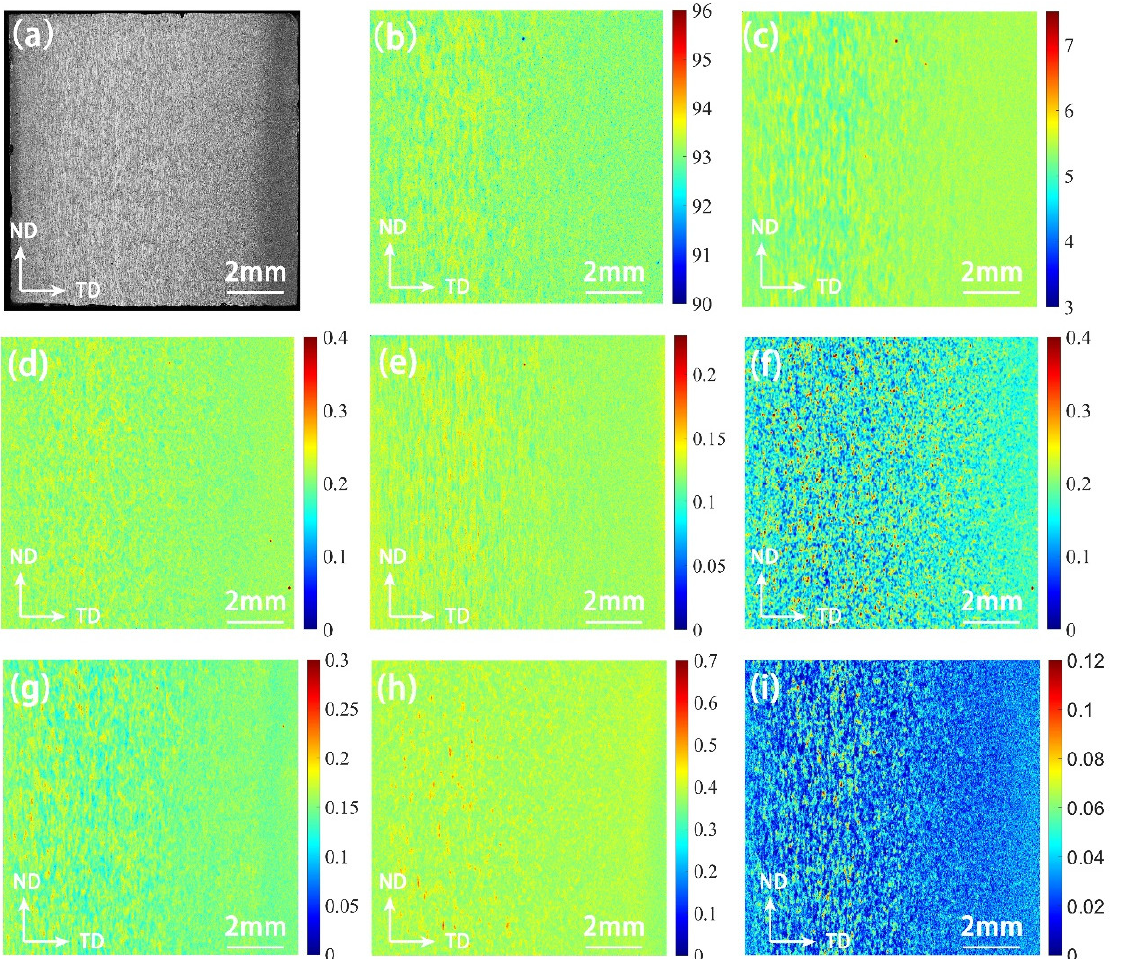
Figure 8. The mapping of T5-10 element contents measured by X-ray fluorescence: ( a ) sample; ( b ) Al element; ( c ) Zn element; ( d ) Cr element; ( e ) Zr element; ( f ) Fe element; ( g ) Cu element; ( h ) Mn element; ( i ) Ti element.